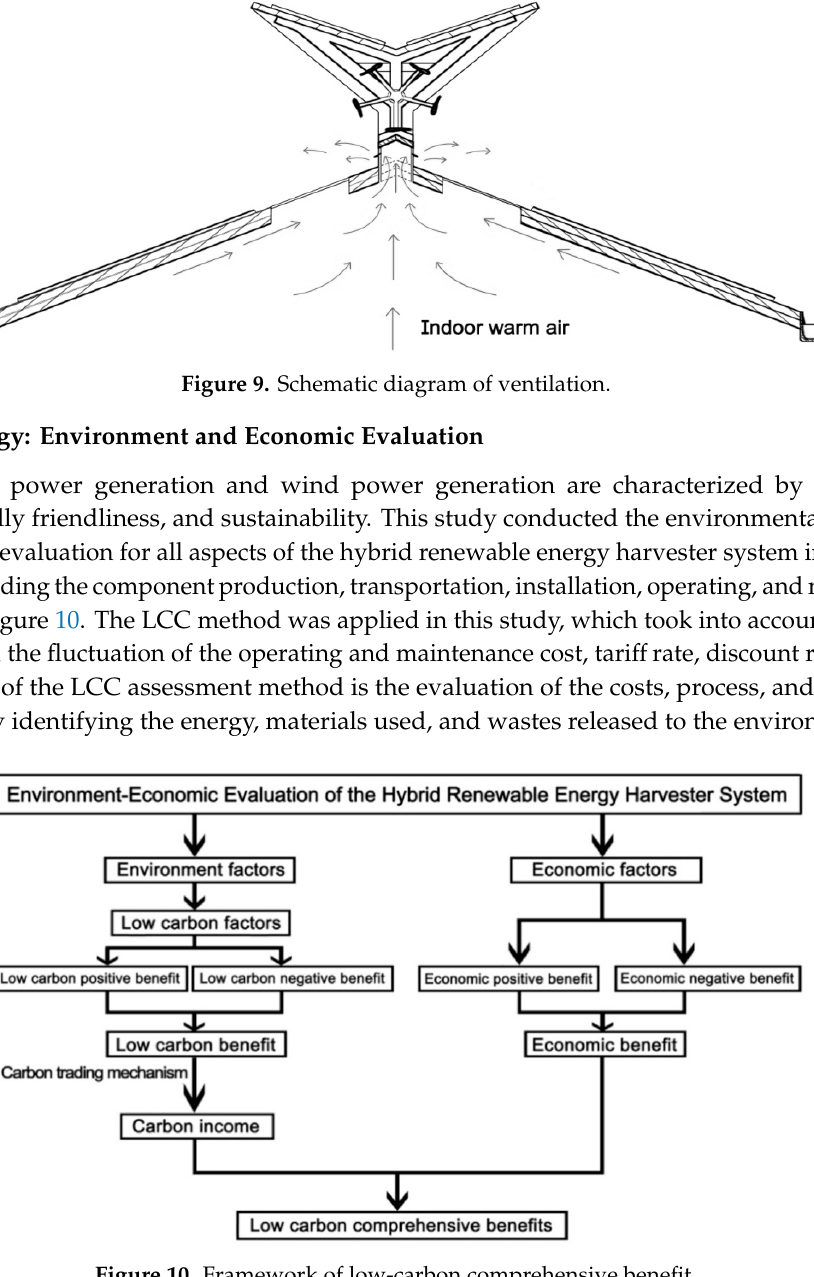
Figure 10. Framework of low-carbon comprehensive benefit.